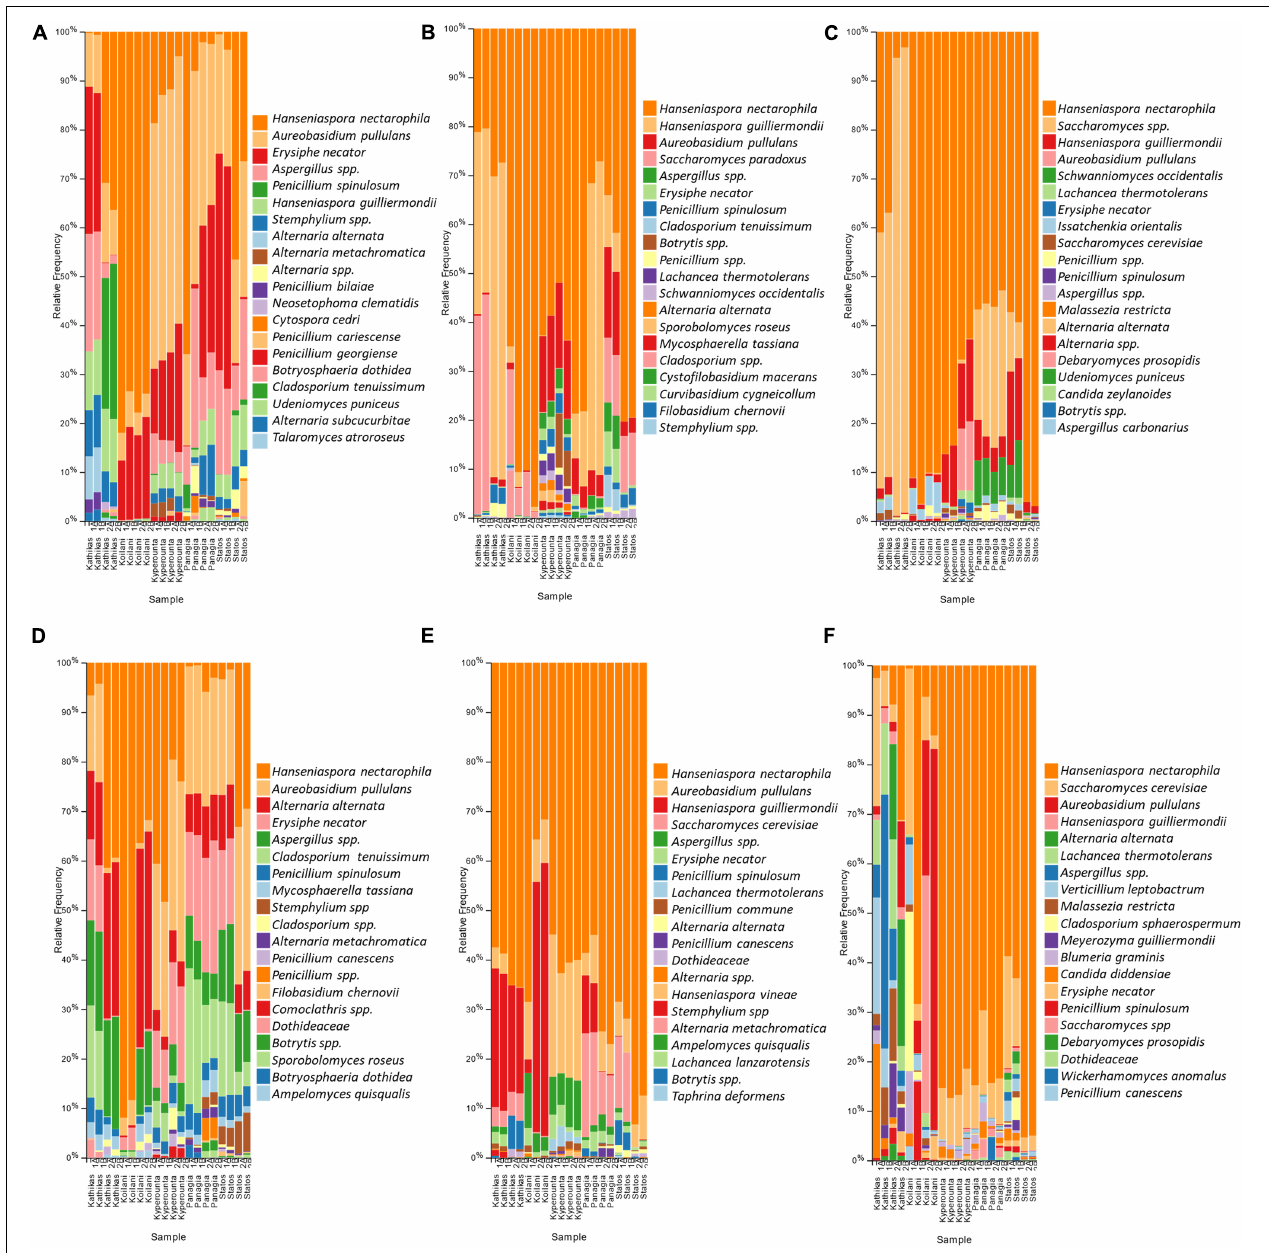
FIGURE 6 | The relative abundance of the twenty most abundant fungi identified at the species level based on ITS loci sequencing for the terroir Kathikas, Koilani, Kyperounta, Panayia, and Statos: (A) for the variety Xynisteri pre-fermentation; (B) for the variety Xynisteri during fermentation; (C) for the variety Xynisteri post-fermentation; (D) for the variety Maratheftiko pre-fermentation; (E) for the variety Maratheftiko during fermentation; (F) for the variety Maratheftiko